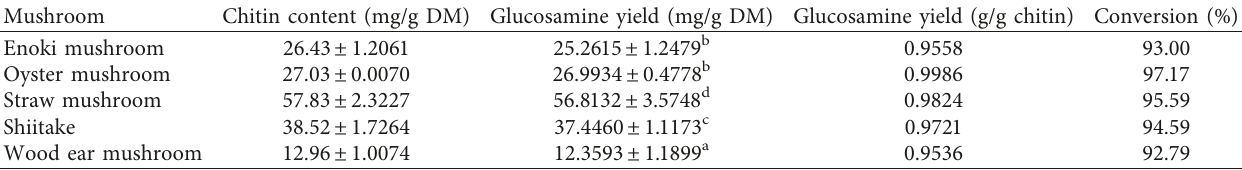
Table 1: The chitin content, glucosamine yield, and conversion of five mushrooms under optimum conditions ∗ .